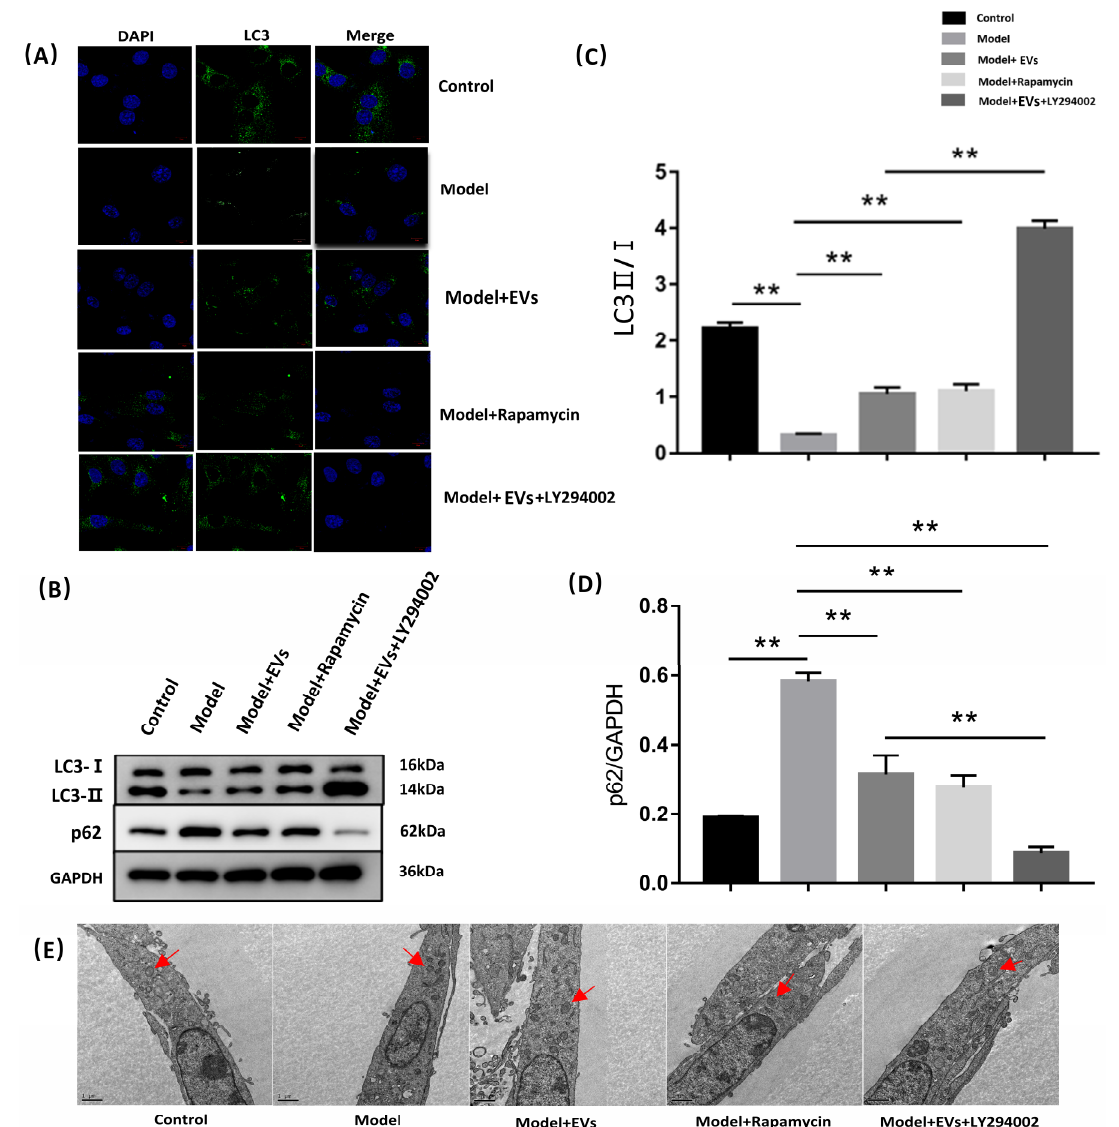
Figure 6. BMSC-EVs regulated autophagy of BMECs. ( A ) Immunohistochemical analysis of au- tophagic marker LC3. Scale bar = 10 μm. ( B ) Western blot analysis of LC3 and P62 in different groups. ( C , D ) Quantification of LC3 and P62 in different groups. ( E ) Morphological changes of autophago- somes were observed by TEM in different groups and the red arrow represents the autophagosome location. Each bar represents the mean ± SD of three independent experiments. ** p < 0.01. DAPI, 4 (cid:48) ,6-diamidino-2-phenylindole; EVs, BMSC-derived extracellular vesicles; GAPDH, glyceraldehyde 3-phosphate dehydrogenase; mTOR, mammalian target of